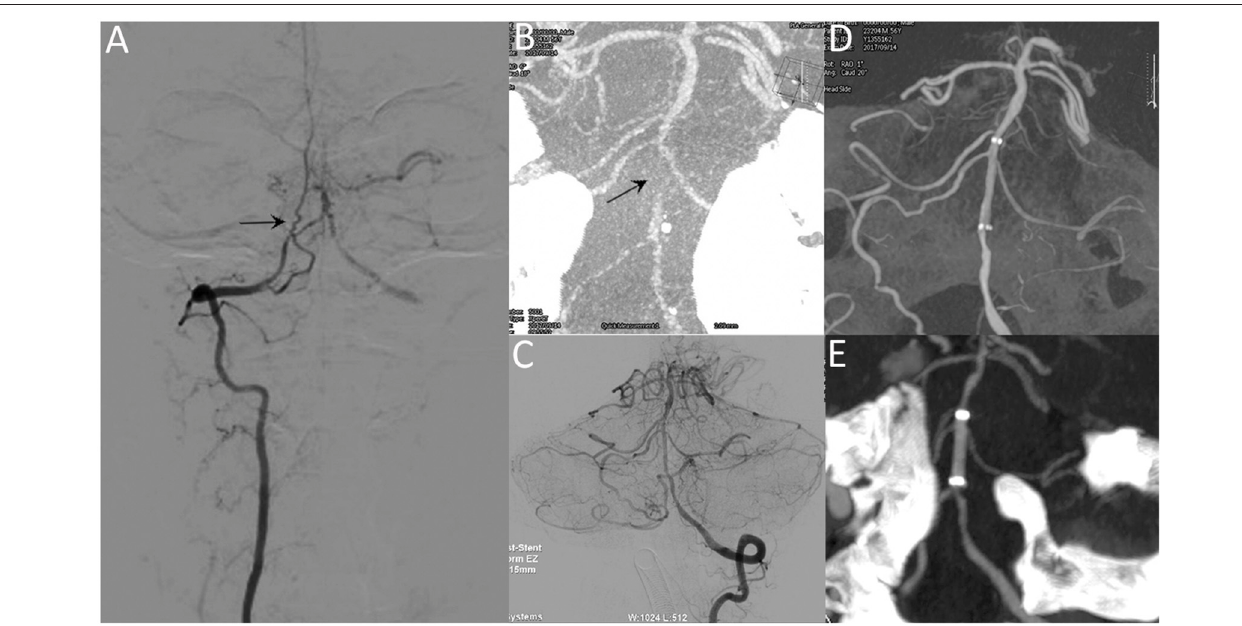
FIGURE 2 | A 53-year-old male with repeated episodes of posterior circulation transient ischemic attacks. Preprocedural DSA image (A) and VasoCT (B) reveal near-occlusion of the basilar artery (arrow). Postprocedural DSA images (C) reveal patency of the basilar artery. Postprocedural XperCT (D) demonstrates good wall apposition of the stent. Follow-up CTA image (E) reveals the patent stent with good apposition 6 months after the procedure. left M1 segment. The procedure was performed uneventfully (Gateway 15/9 mm for pre-stent angioplasty, Neuroform EZ 3/20 mm for stenting), with a 20% residual stenosis of the artery. When the patient regained consciousness